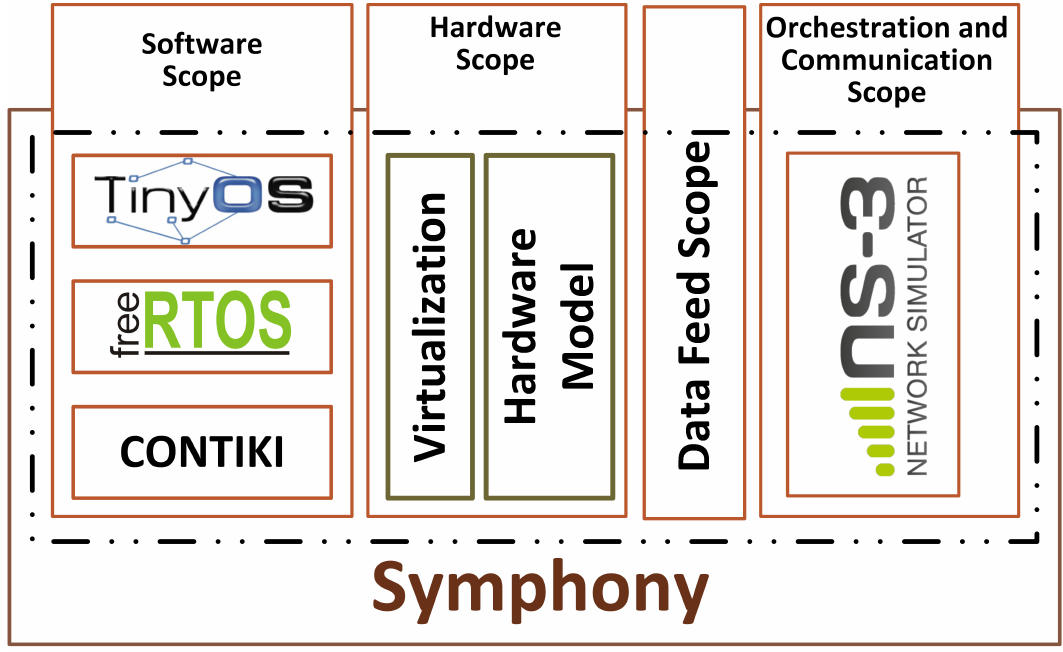
Figure 1. A high level architectural overview of